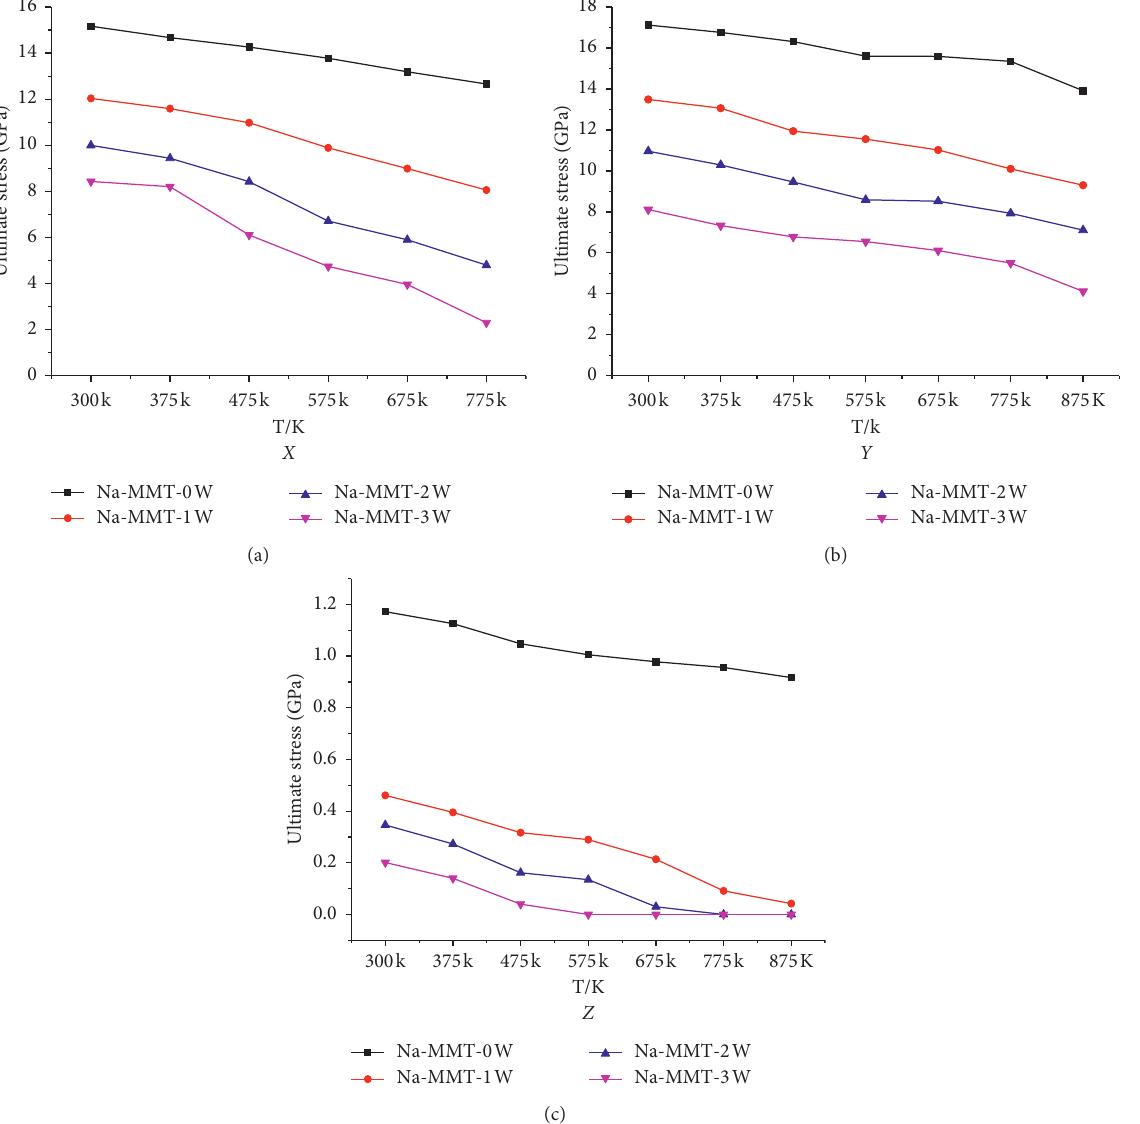
Figure 7: Ultimate stress in the X , Y , and Z directions of hydrated Na-MMT at different